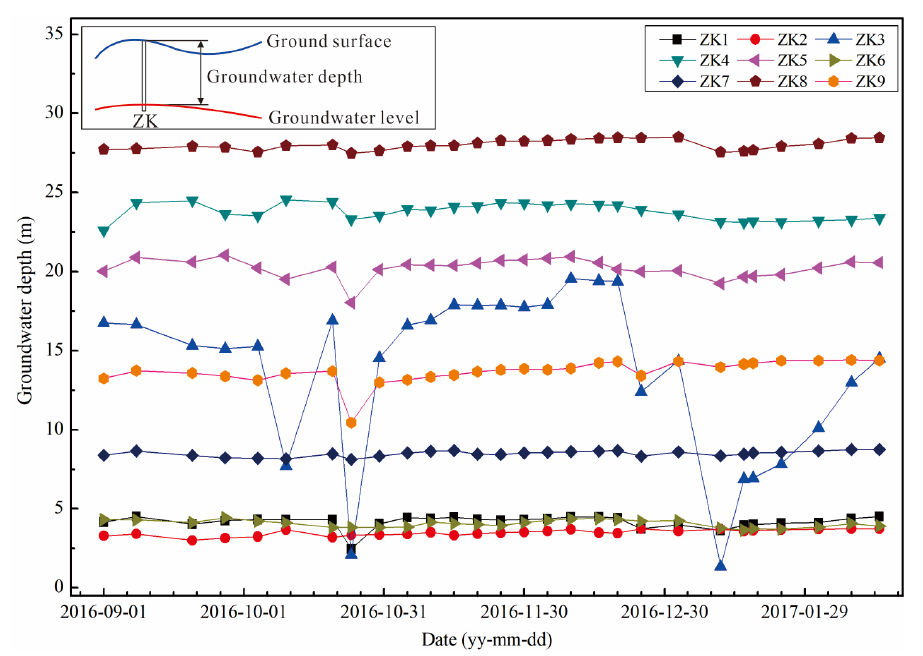
Figure 4. Variation in the groundwater depth.